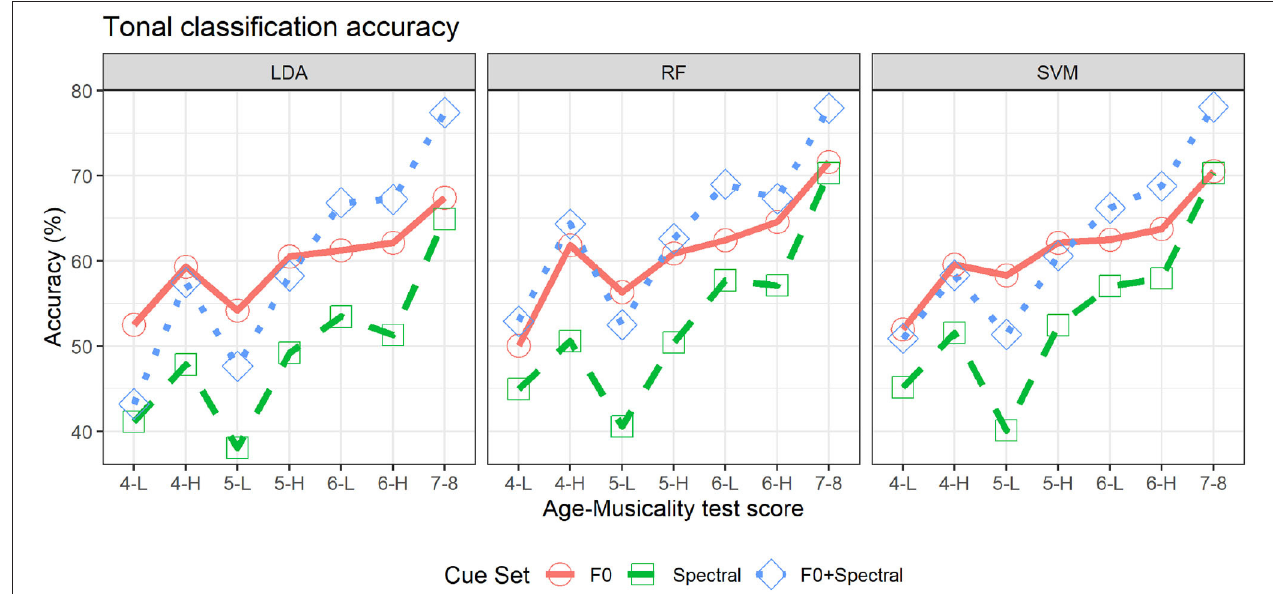
FIGURE 2 | Average tonal classification accuracy from 100 trials of 10-fold cross-validation for each age (4, 5, 6, and 7–8 years) and musicality group (H if median and above, and L if below the median; only available for children between 4 and 6 years of age), using only F0 cues (red solid line), only spectral cues (green dashed line), or both F0 and spectral cues (blue dotted line). Three classification algorithms were tested (LDA: left panel, RF: middle panel, and SVM: right